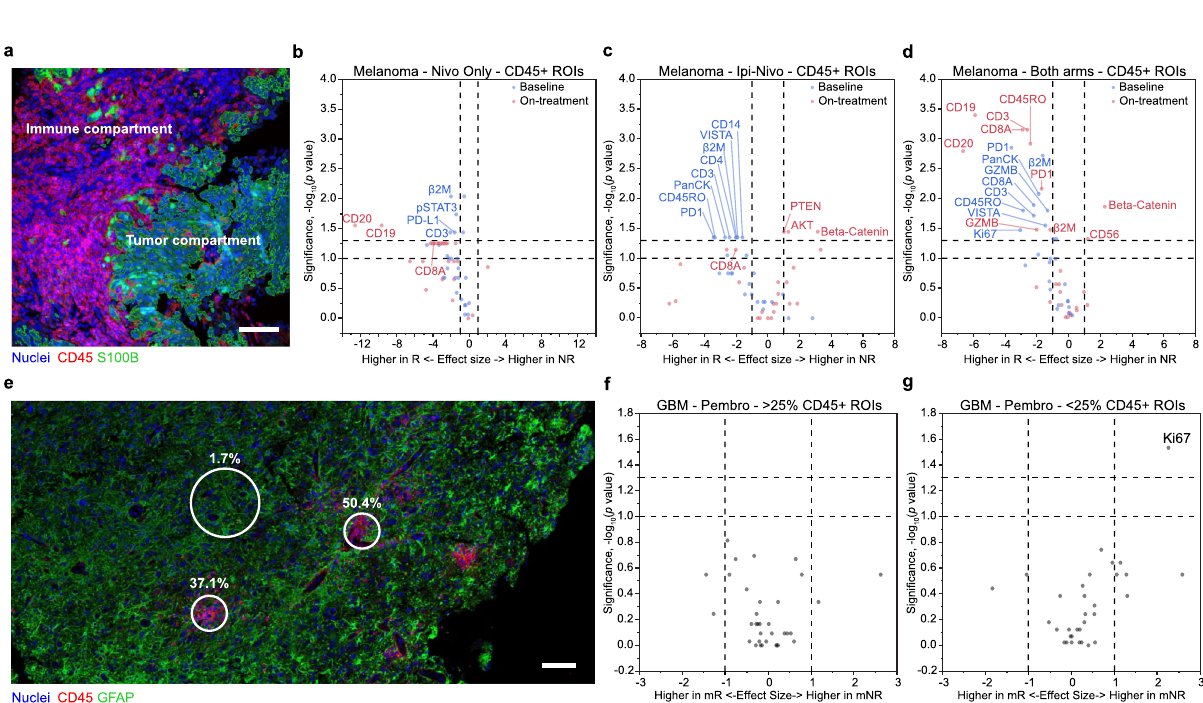
Fig. 2 Regions of interest de fi nition and differential protein expression. a Fluorescent micrograph of a representative region in a melanoma sample ( n = 39) stained for nuclei (blue), CD45 (red), and S100B (green). The immune compartment (contoured with red lines) and the tumor compartment (contoured with green lines) were identi fi ed via thresholding the fl uorescence intensity of CD45 marker. Scale bar is 100 µ m. b – d Volcano plots of two- sided Mann – Whitney U -test comparisons of the protein expressions between RECIST responders and nonresponders in baseline (blue) and on-treatment (red) melanoma samples. The samples were either from the nivolumab (nivo) cohort ( b ) ( n = 9 nonresponders and 3 responders at baseline, n = 7 nonresponders and 2 responders on-treatment), ipilimumab plus nivolumab (ipi-nivo) cohort ( c ) ( n = 2 nonresponders and 8 responders at baseline, n = 3 nonresponders and 5 responders on-treatment), or both arms combined ( d ) ( n = 11 nonresponders and 11 responders at baseline, n = 10 nonresponders and 7 responders on-treatment). Expression of proteins was assessed in the immune compartments of the tissue and quanti fi ed as the average count per area of assayed tissue. e Fluorescent micrograph of a representative region in a GBM sample ( n = 14) stained for nuclei (blue), CD45 (red), and GFAP (green). Three representative geometric ROIs (in white) were designated as immune-cell rich (immune cell proportion: 37.1% and 50.4%) and immune- cell poor (immune cell proportion: 1.7%). Scale bar is 100 µ m. f , g Volcano plots of two-sided Mann – Whitney U -test comparisons of the protein expressions between molecular responders (mR) and molecular nonresponders (mNR) in GBM samples treated with pembrolizumab (pembro). The responses were generated based on a 23-gene molecular signature. Expression of proteins was quanti fi ed as average count per area of assayed tissue, which were either in the immune-cell rich regions ( f ) ( n = 8 mNRs and 4 mRs) or immune-cell poor regions ( g ) ( n = 8 mNRs and 6 mRs). For plots in ( b – d ), ( f ), and ( g ), the dashed horizontal lines represent the p value cutoffs ( p < 0.10 and p < 0.05) and the dashed vertical lines represent the effect size cutoffs (effect size > |1|). ROIs regions of interest. Source data are provided as a Source Data fi